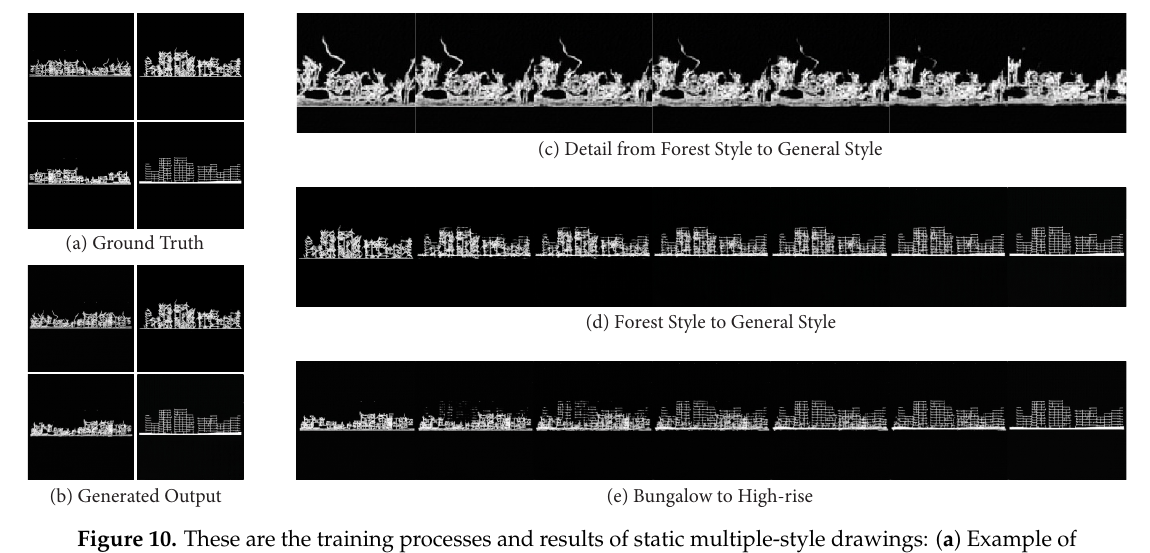
Figure 10. These are the training processes and results of static multiple-style drawings: ( a ) Example of input data. ( b ) Selected output fake images. ( c ) Detail of style transfer from forest style to general